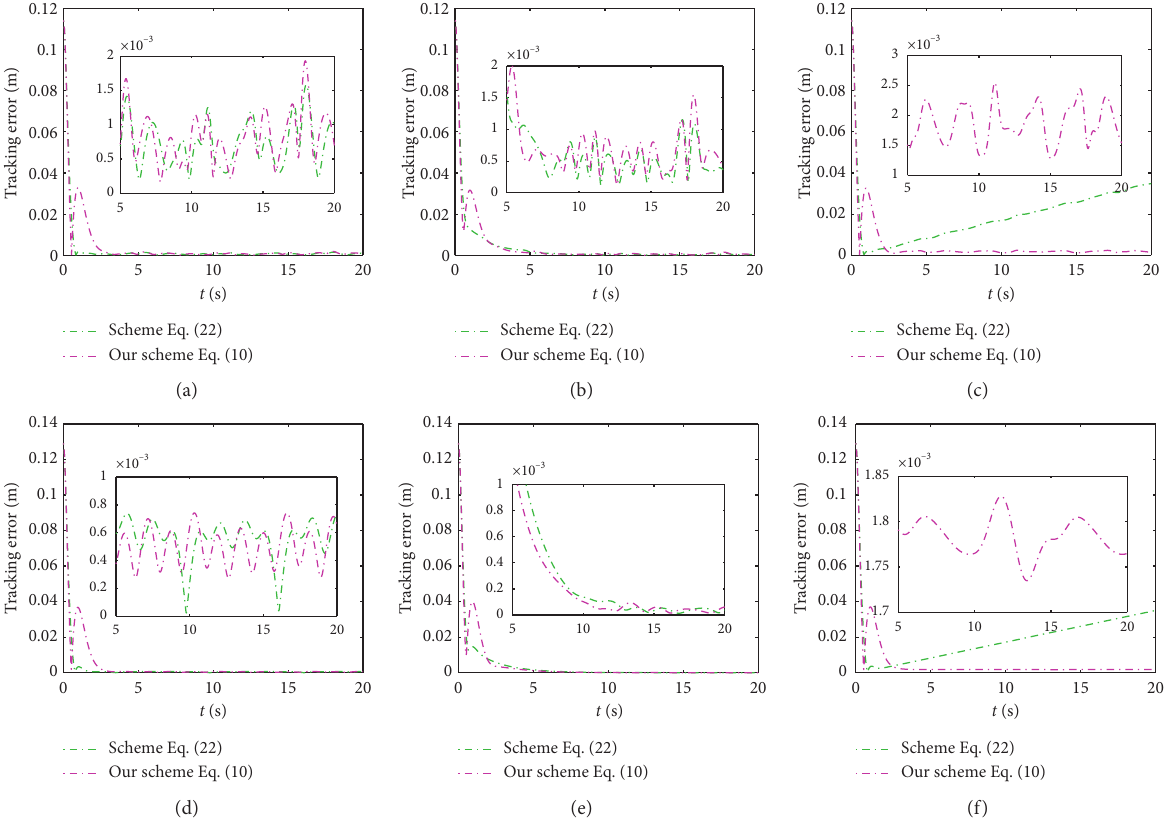
Figure 4: (a–f) Tracking error comparison for butterfly and triangle trajectory tracking tasks under sine-form noise, exponential noise, and linear noise, respectively. Top: butterfly trajectory. Below: triangle